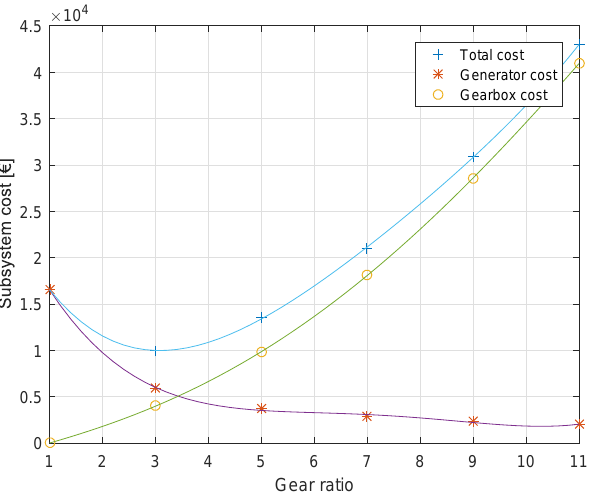
Figure 15. Gearbox and generator costs for different gear ratios at the power rating of 1.5 MW.